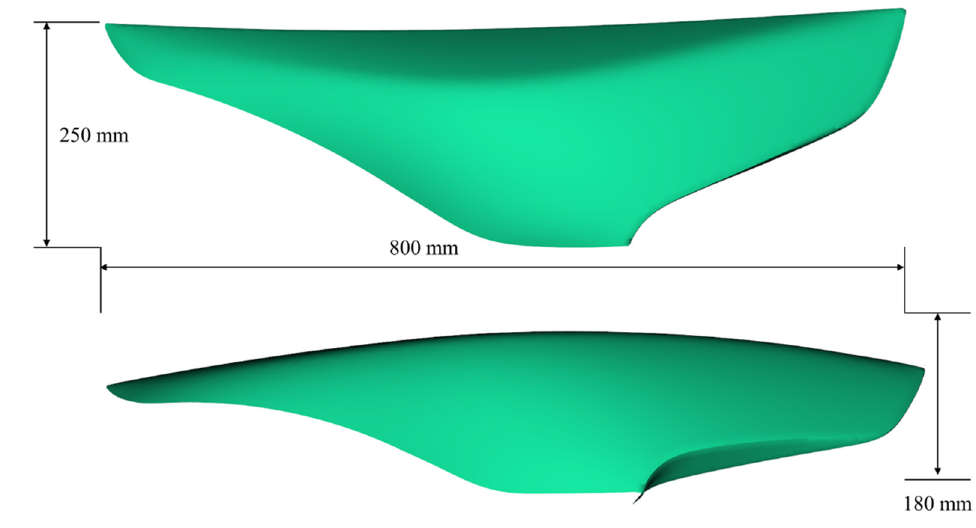
Figure 9. Car headlamp lens cover shape with geometry information.